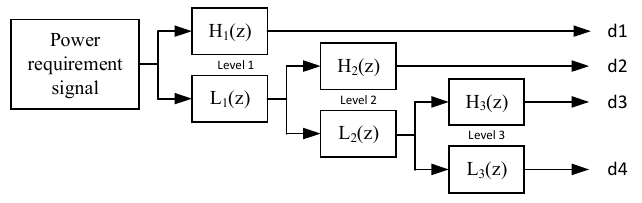
Figure 13. Decomposition process of the wavelet transform [30].